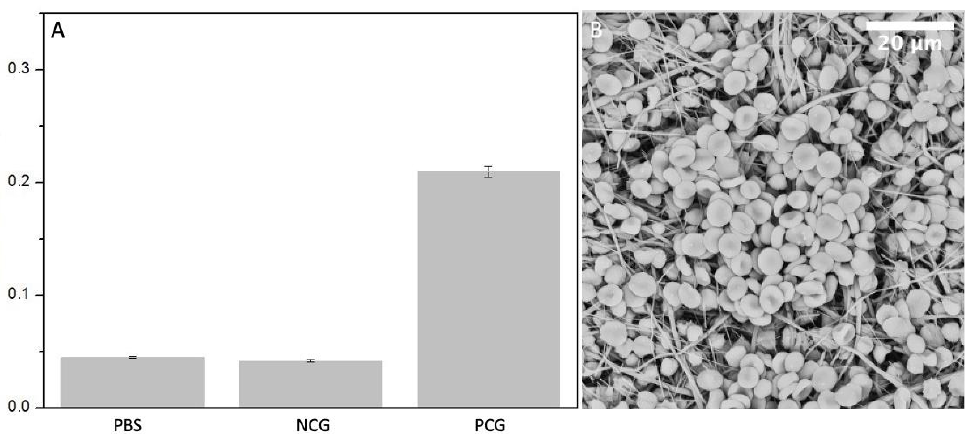
Figure 8. ( A ) Measured absorbance after haemolysis assay in positive control group PCG, negative control group NCG and electrospun PBS ( n = 5). ( B ) SEM micrograph of electrospun PBS after incubation with diluted whole blood.